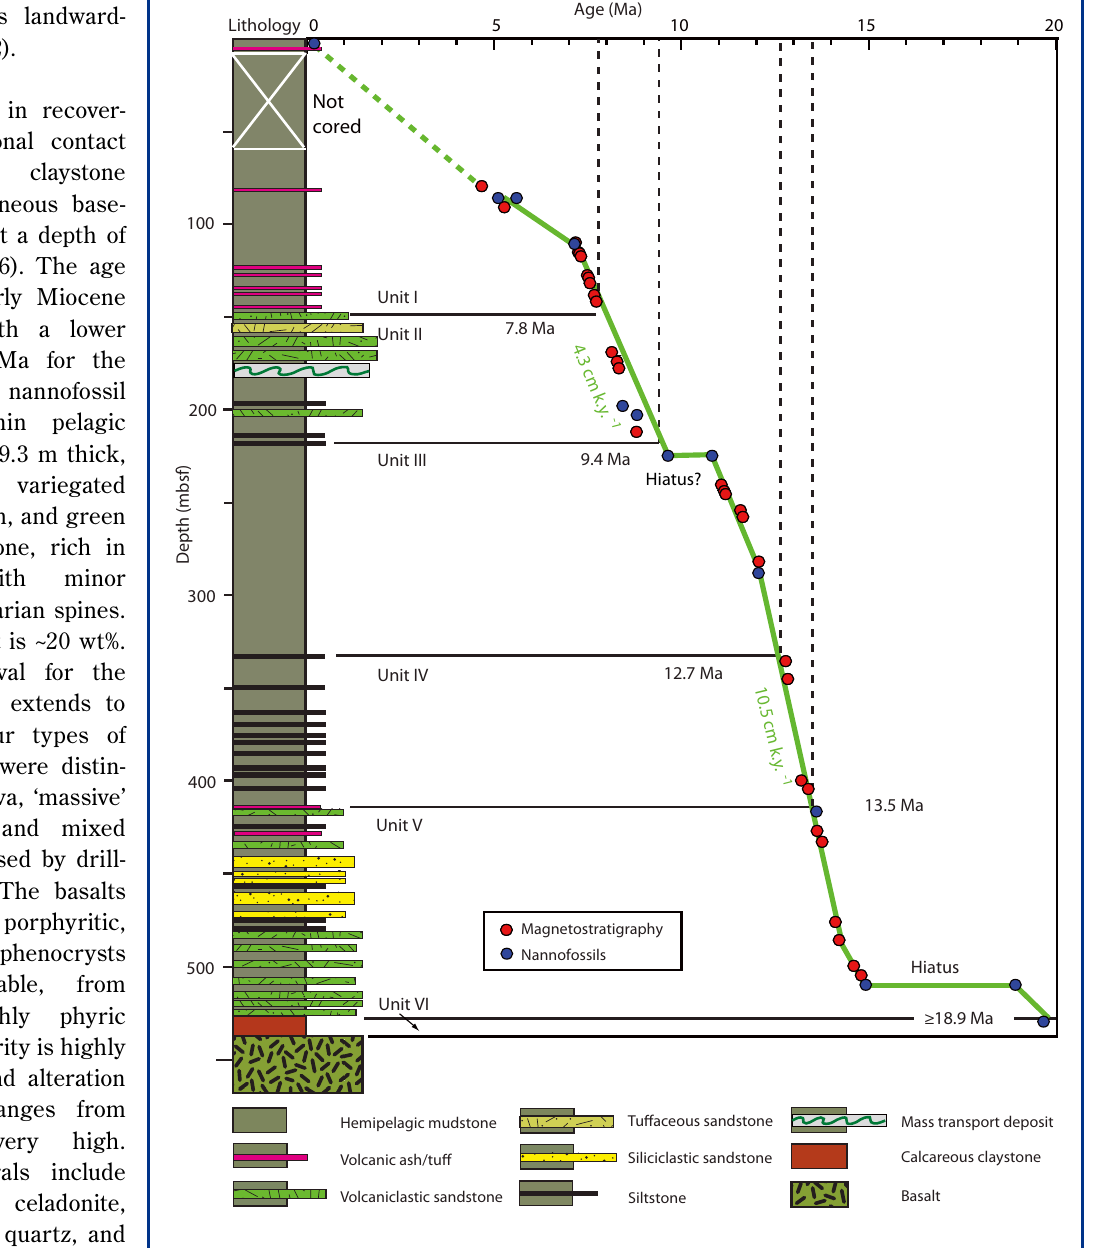
Figure 7. Integrated age-depth model for Hole C0012A using constraints from biostratigraphy and